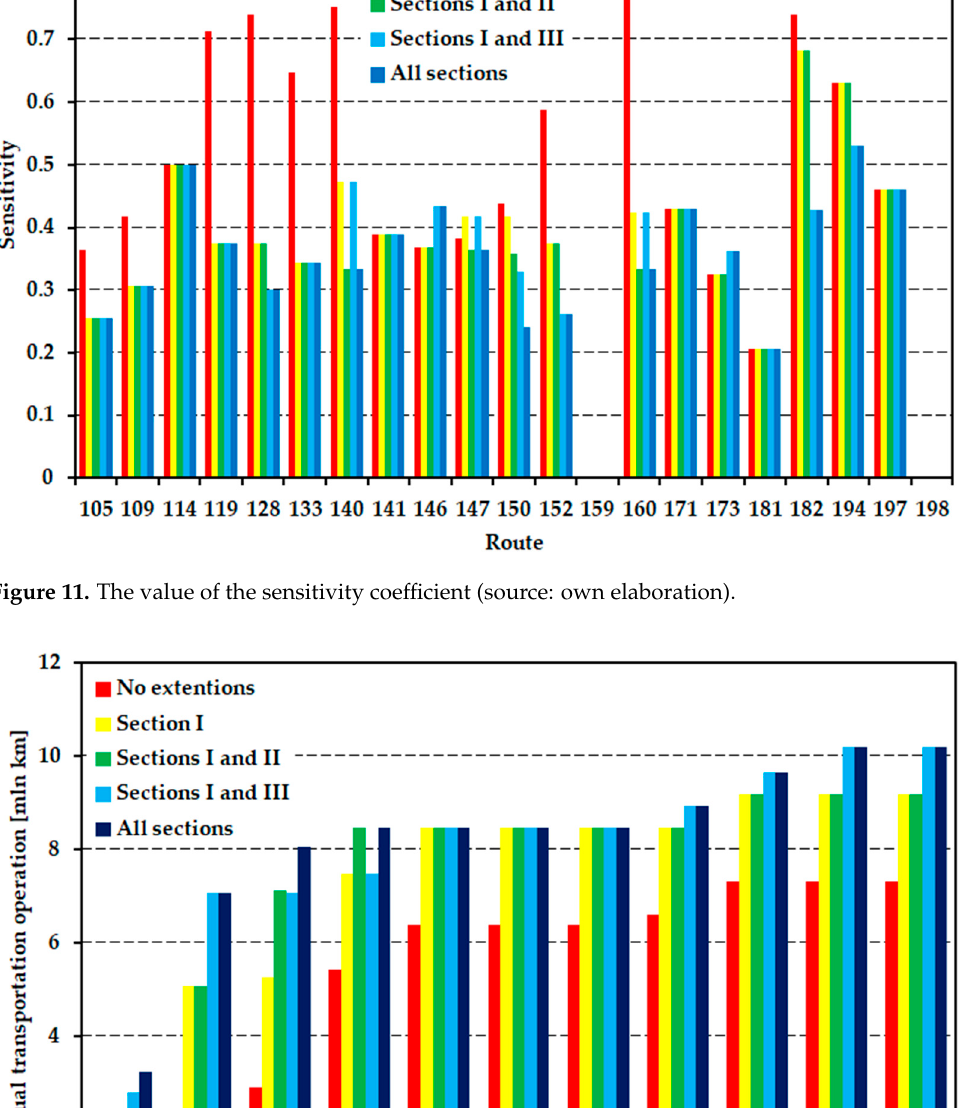
Figure 12. Potential of increasing the transportation work by implementation of dynamic charging based on the existing trolleybus infrastructure in Gdynia in the function of charging power for several variants of trolleybus network extension (source: own elaboration).